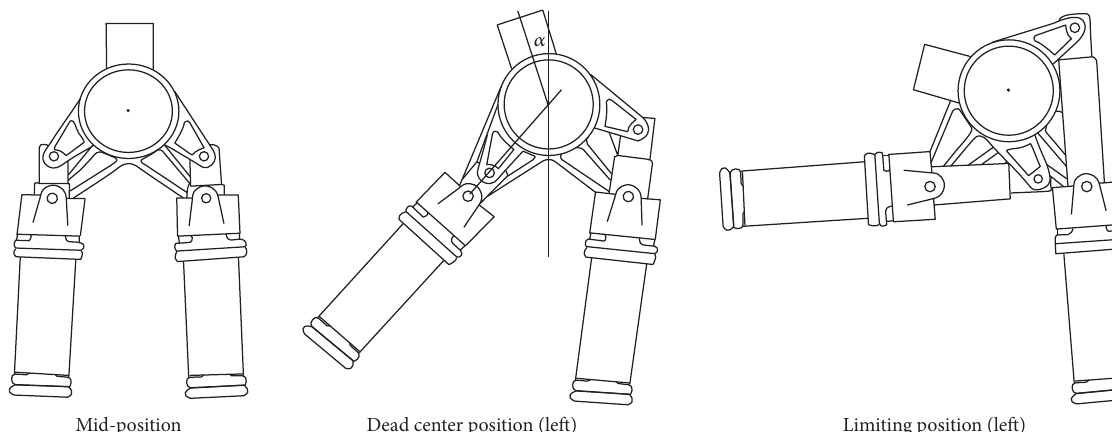
Figure 1: Three node states definition of the moving process.